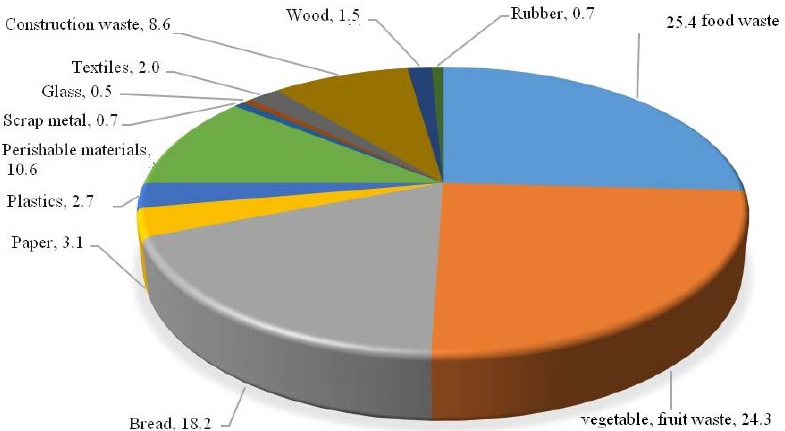
Fig. 2: Percentage of household waste generation by types